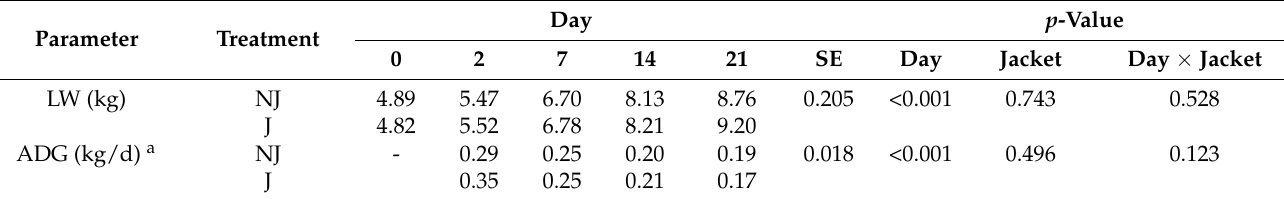
Table 1. Mean live weight (LW; kg) and average daily gain (ADG; kg/d) of non-jacketed (NJ) and jacketed (J) lambs for the first 21 days of